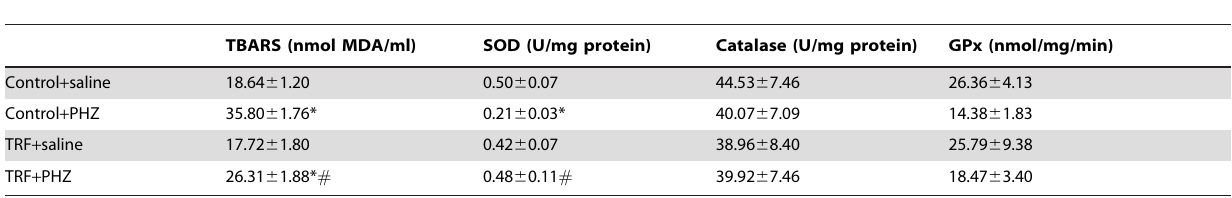
Table 1. Oxidative stress markers in red blood